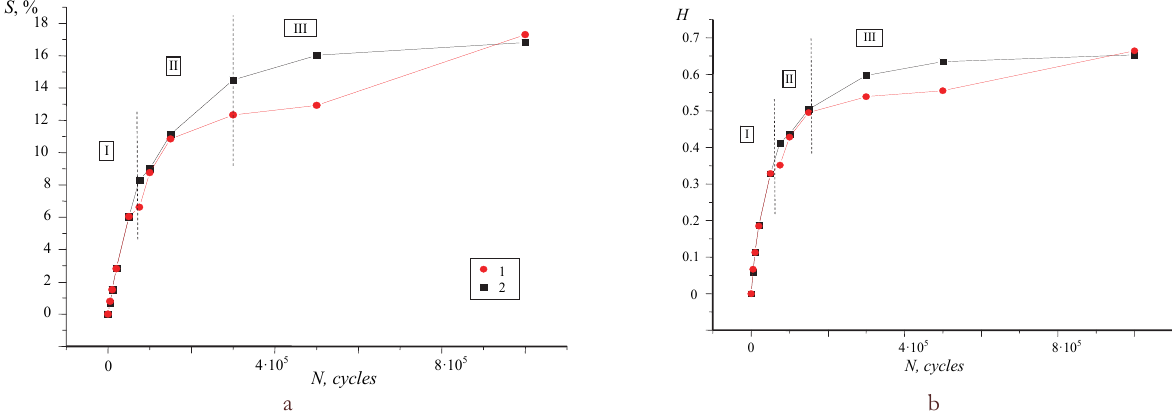
Figure 2: Dependence of the deformed (damaged) area (S) –(a), and the Shannon entropy (H) – (b) vs the number of cycles.